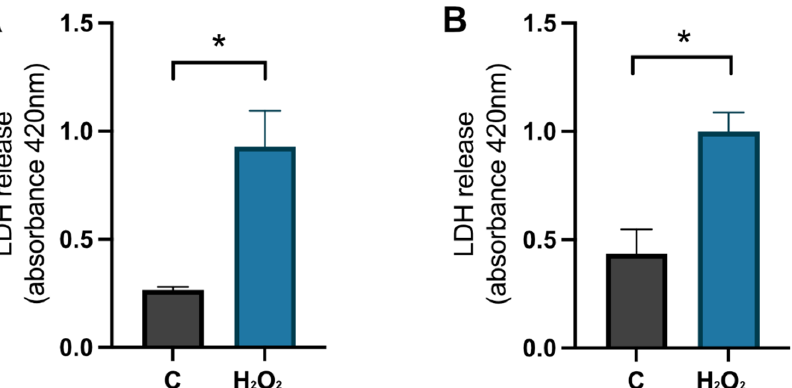
Figure 7. The effect of hydrogen peroxide on membrane integrity. The results of LDH release on day 9 for control cells (C) treated with MQH 2 O and hydrogen-peroxide treated cells (H 2 O 2 ). There was a significant increase in LDH release for the cells treated with hydrogen peroxide when compared to control cells in ( A ) hippocampal cultures ( n = 3) and ( B ) cortical cultures ( n = 3). All data are presented as means ± SEM, * p -value < 0.05.